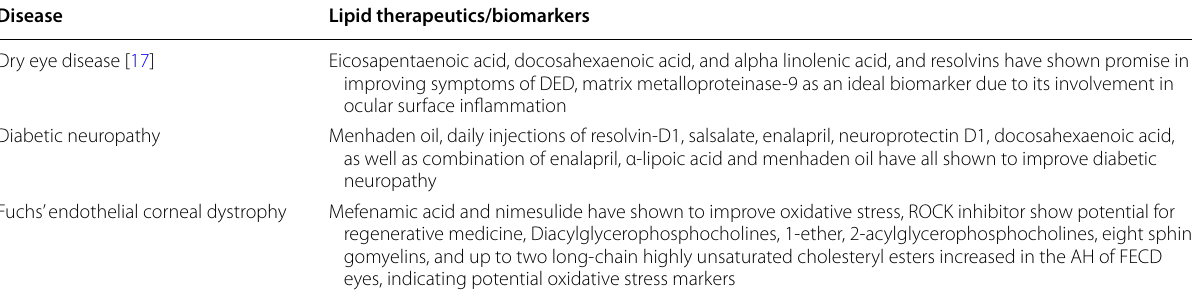
Table 1 Lipid therapeutics/biomarkers available for corneal diseases Disease Lipid therapeutics/biomarkers Dry eye disease